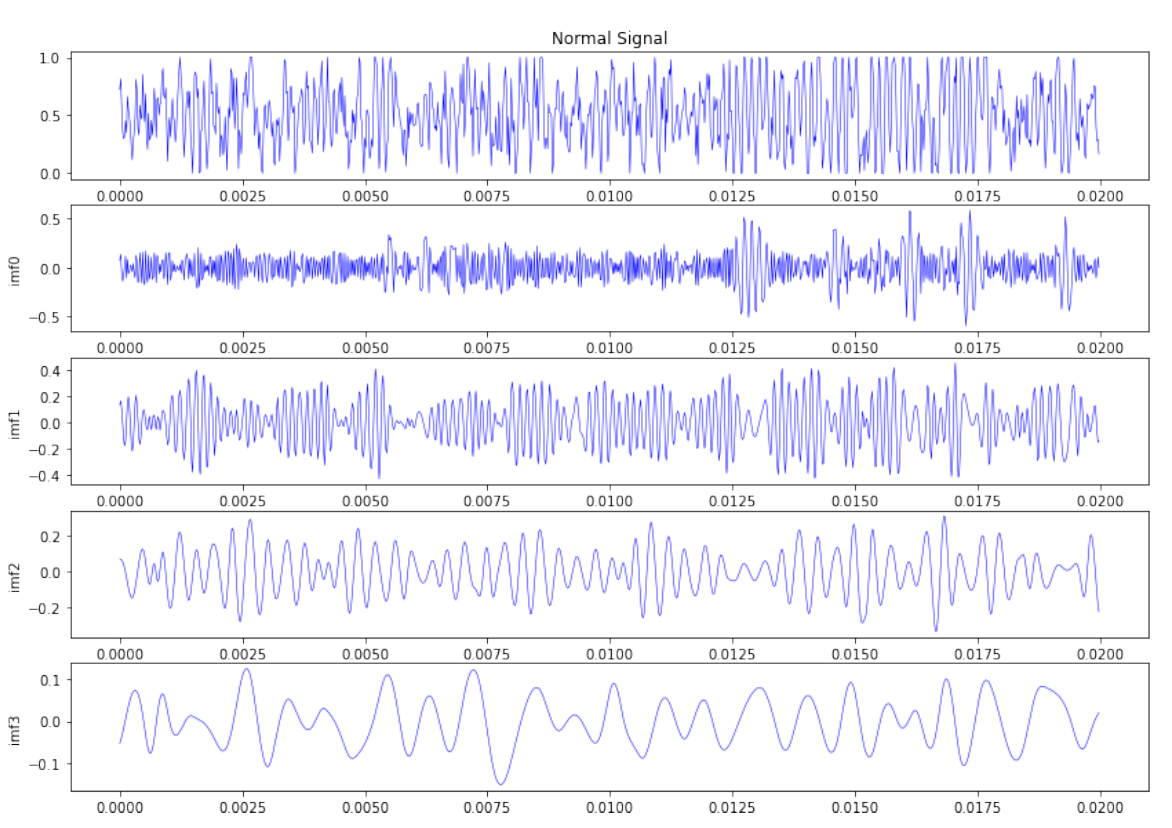
Figure 8. The normal vibration signal and the former four order IMF sub-signals.